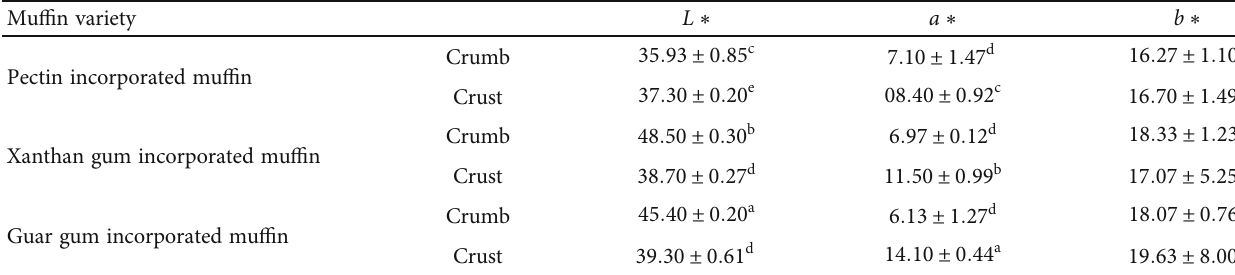
Table 2: Average chromameter values for three di ff erent mu ffi ns.